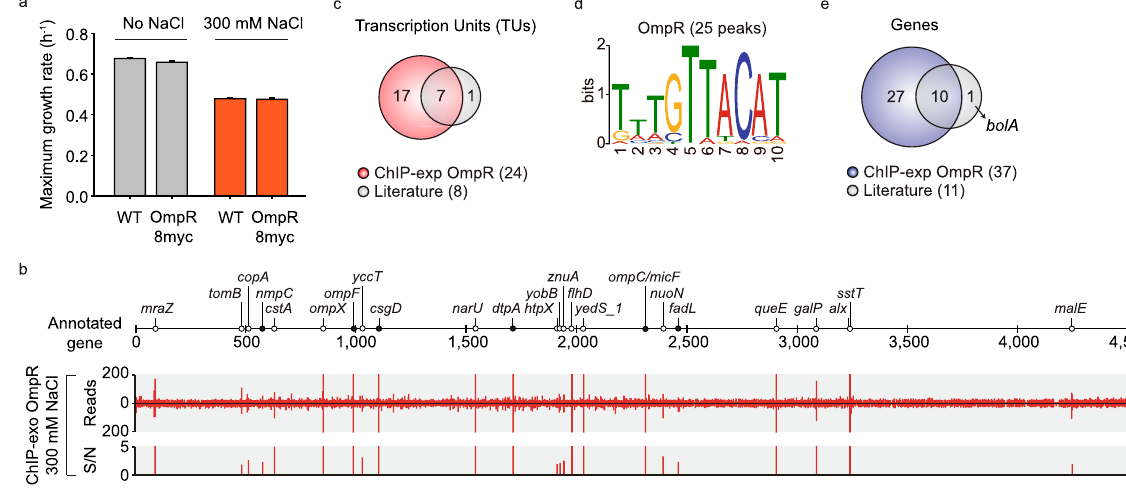
Figure 1. Genome-wide profiles of OmpR-binding sites. ( a ) Effect of myc-tag of OmpR on cellular growth in response to osmotic stress (0.3 M NaCl) ( b ). An overview of OmpR-binding profiles across the E . coli genome at mid-exponential growth phase under osmotic stress condition. Black and white dots indicate previously known and newly found OmpR-binding sites, respectively. S/N denotes signal to noise ratio. ( + ) and ( − ) indicate forward and reverse reads, respectively. Binding peaks that overlap with Mock-IP signal were eliminated. ( c , d ) Comparison of genome-wide OmpR-binding sites obtained from this study (ChIP-exo) under osmotic stress with the known binding sites from the literature in terms of ( c ) transcription units and ( d ) genes. ( e ) Sequence motif logo represents the DNA binding motifs of OmpR from 25 binding